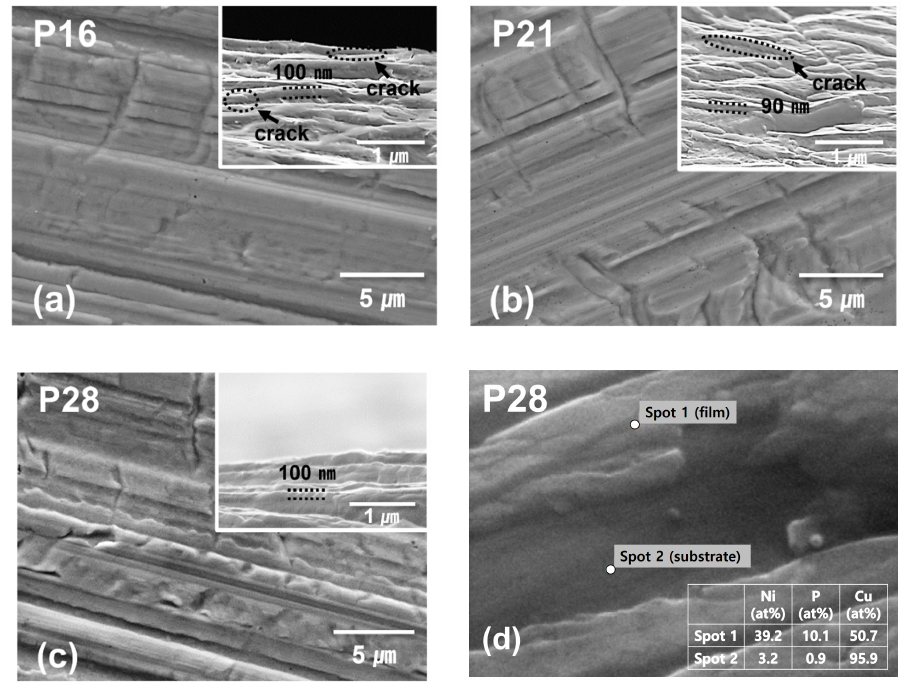
Figure 1. Scanning electron micrographs of the nickel phosphide thin films with different phosphorus (P) contents: ( a ) sample P16 (16 at% P), ( b ) sample P21 (21 at% P), and ( c ) sample P28 (28 at% P) in Table 1. Inset figures are the magnified inclined images. ( d ) represents the magnified image and composition of Ni-P electrodeposits (spot 1) and Cu substrate (spot 2) in sample P28.